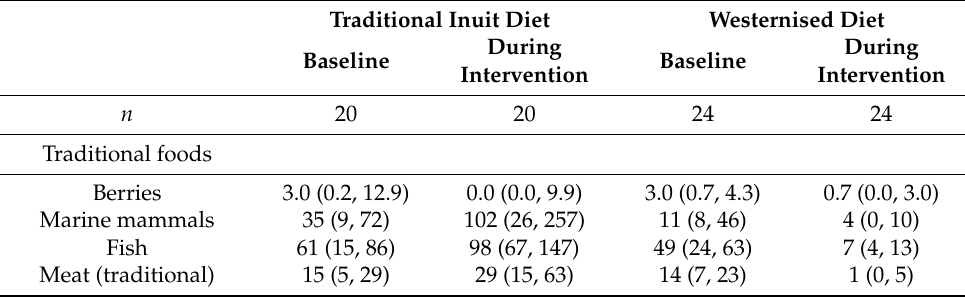
Table 2. Food intake (grams/day) at baseline and during the intervention ( n =